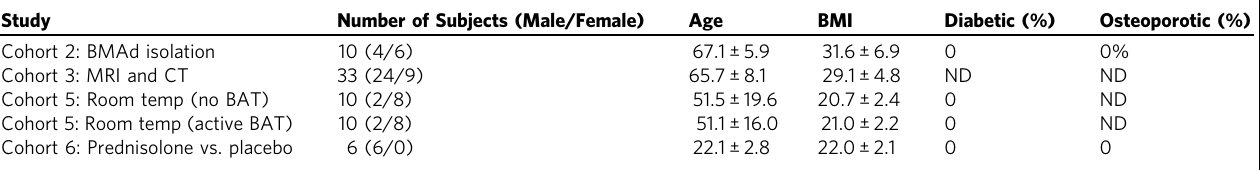
Table 1 Human subject characteristics. Age and BMI are mean ± SD. ND, not